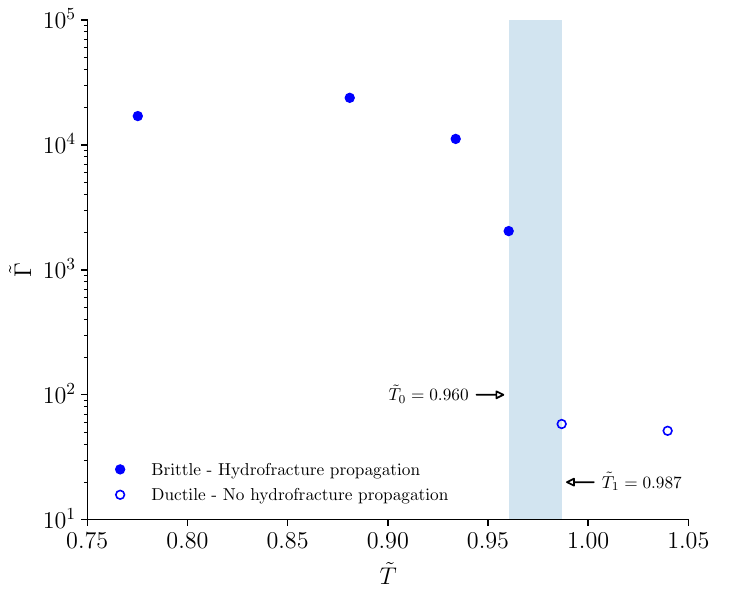
Figure 9. The normalized cumulative acoustic emission energy ˜ Ŵ is a function of the normalized temperature Ŵ decreases with increasing temperature and marks a stark transition of the hydro-fracturing behaviour at the T : ˜ ˜ glass transition temperature T g 0.987 at ˜ T ≥